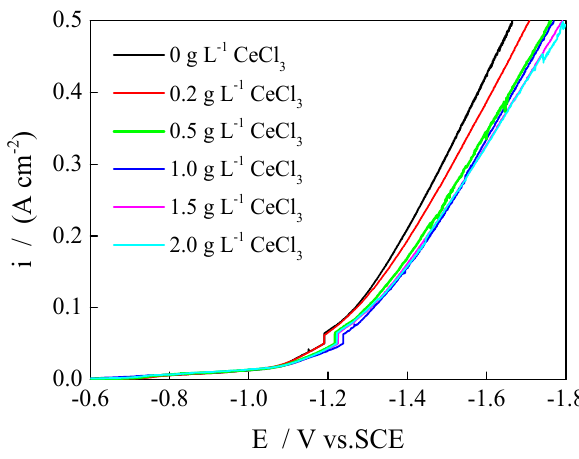
Figure 7. Cathodic polarization curves of the samples in the plating solutions with di ff erent concentrations of CeCl 3 .